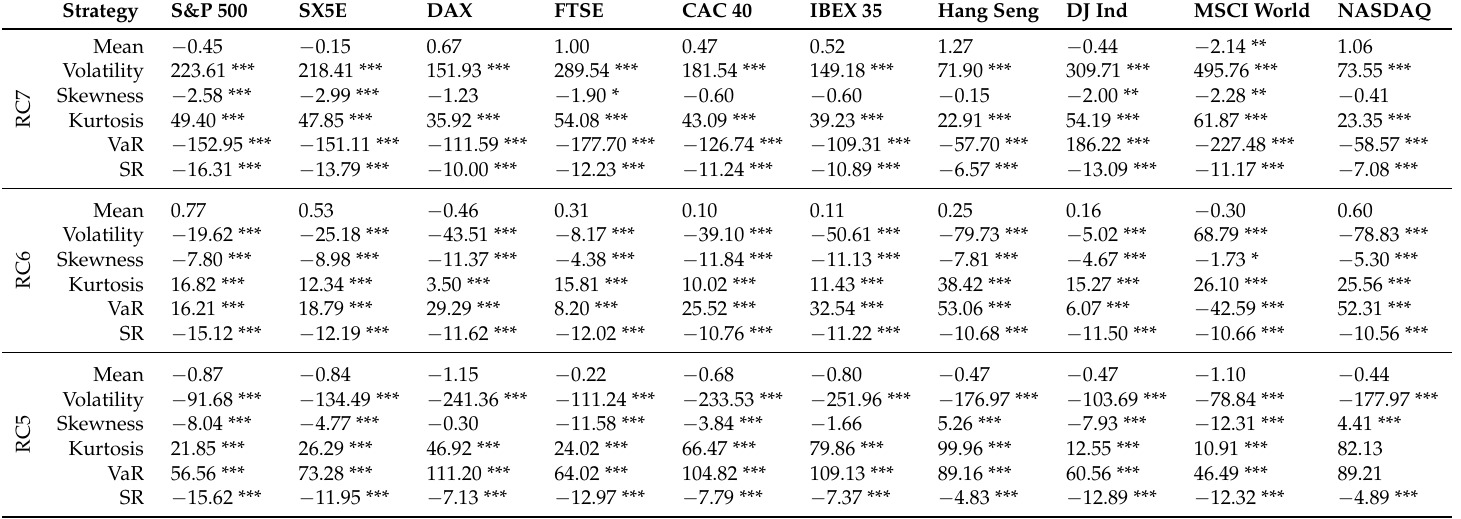
Table 6. Results of the paired t -test on the distribution parameters. Significance at a confidence level of 99%, 95%, 90% is in indicated with ***, **, *, respectively. The returns are generated with a GJR(1,1)-model, where the parameters for each index are estimated on the full history available and a t -distribution is assumed for the innovations. We generate 10,000 price paths of 1040 weekly returns and apply the risk on-risk off strategy. Then, the distribution parameters and the Sharpe ratios are calculated, and the t -test is performed against the same parameters of the passive strategy. There is no significant difference in mean return, but the strategies based on volatility display significantly lower